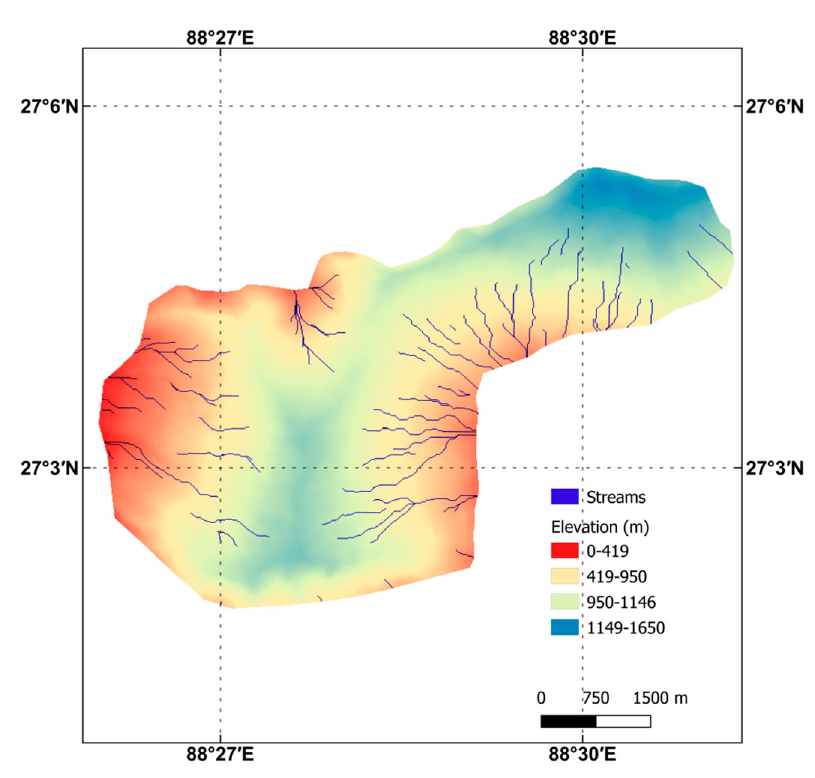
Figure 2. Drainage map of Kalimpong, overlaid on a digital elevation model [43].